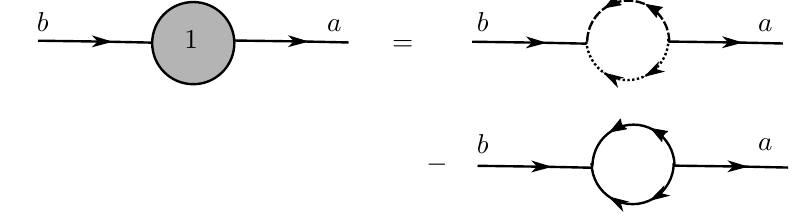
Figure 5 . The one-loop correction to the scalar propagator. The (cid:12)rst diagram on the right hand side is the Q -contribution due the fundamental hypermultiplets; the second diagram is the H -contribution due the adjoint hypermultiplet and so it comes with a minus